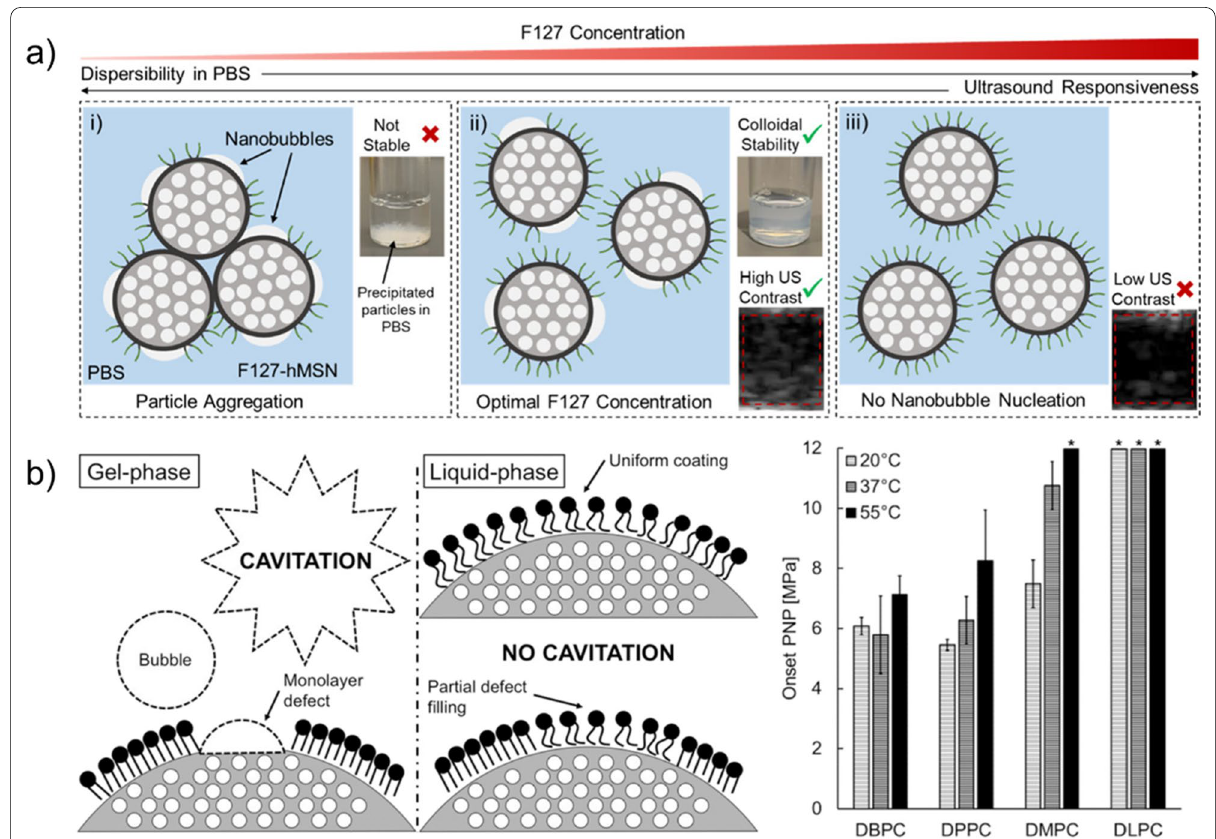
Fig. 4 a Schematic of the proposed mechanism for GSNs with high acoustic activity and good dispersibility in buffer solutions. Adapted from reference [39], https:// pubs. acs. org/ doi/ 10. 1021/ acsom ega. 0c033 77, 2020, further permissions related to the material excerpted should be directed to the American Chemical Society. b Schematic showing the defect hypothesis for phospholipid coated hydrophobic MSNs (left). Cavitation onset peak negative pressures for hydrophobic MSNs coated with different lipids with different tail lengths (right). Adapted from reference [79], Copyright 2019, American Chemical